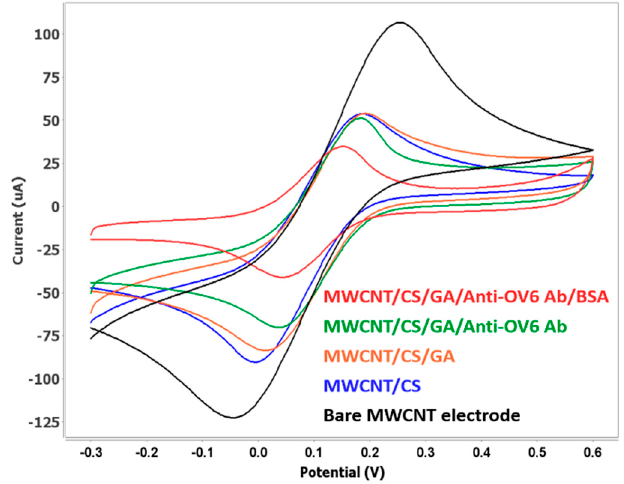
Figure 4. Cyclic voltammetry spectra of the functionalized MWCNT/CS/GA/anti-OV6 Ab/BSA electrode at a scan rate of 50 mV/s.